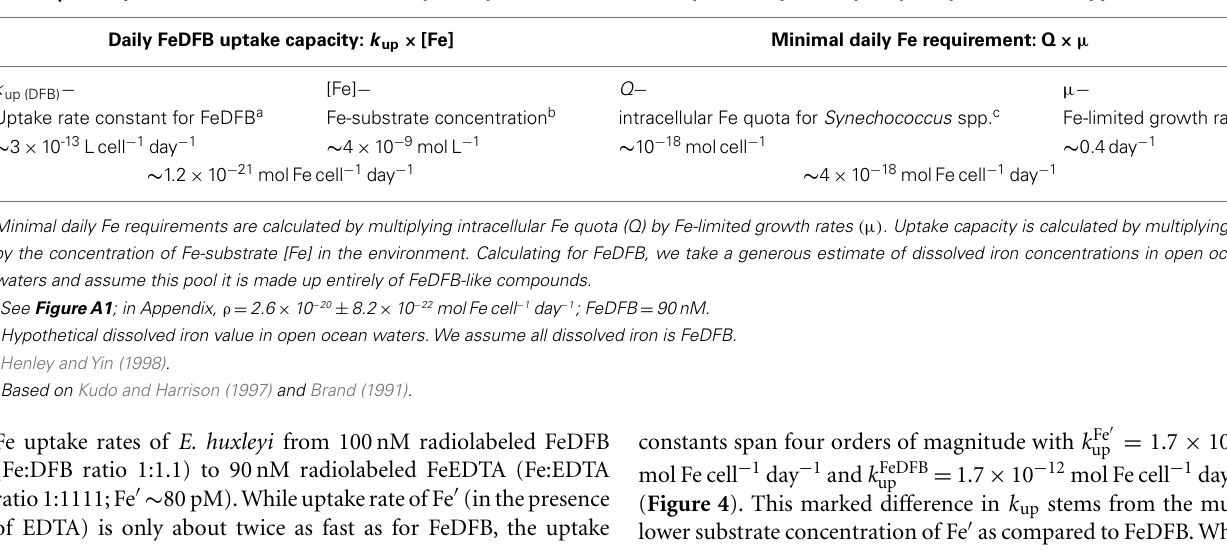
sufficient excess of Fe to rule out the presence of Fe (cid:2) (which would bias uptake rate since Fe (cid:2) is taken up more readily than FeL). But L:Fe should be minimal to prevent ligand from competing with cells for Fe (and thus decreasing uptake rates).